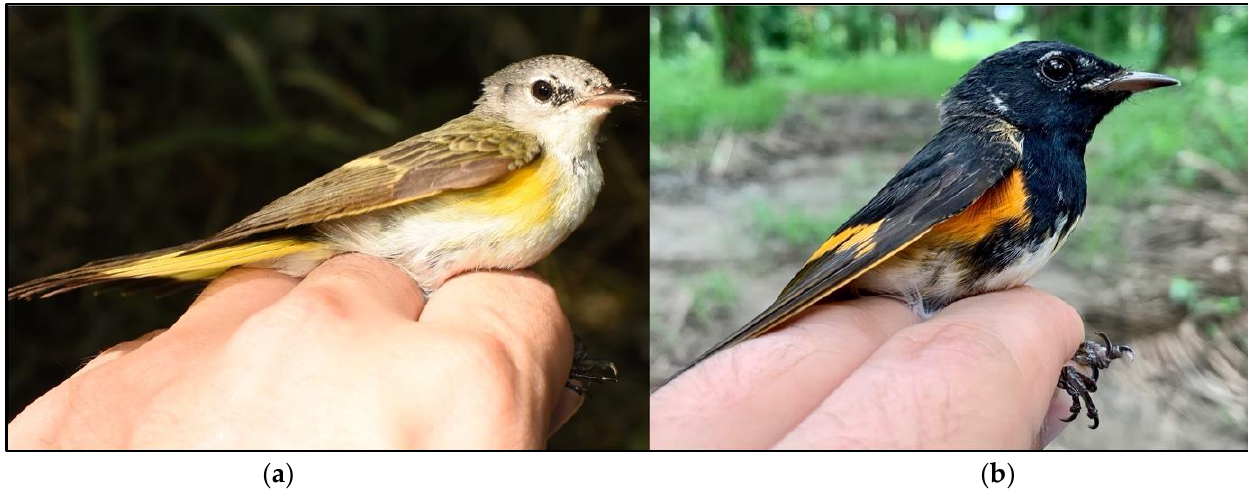
Figure 2. Pictures of the first year male American Redstart (SR6) captures in the first ( a ) and the second ( b ) wintering season, in oil palm plantations, Tabasco,